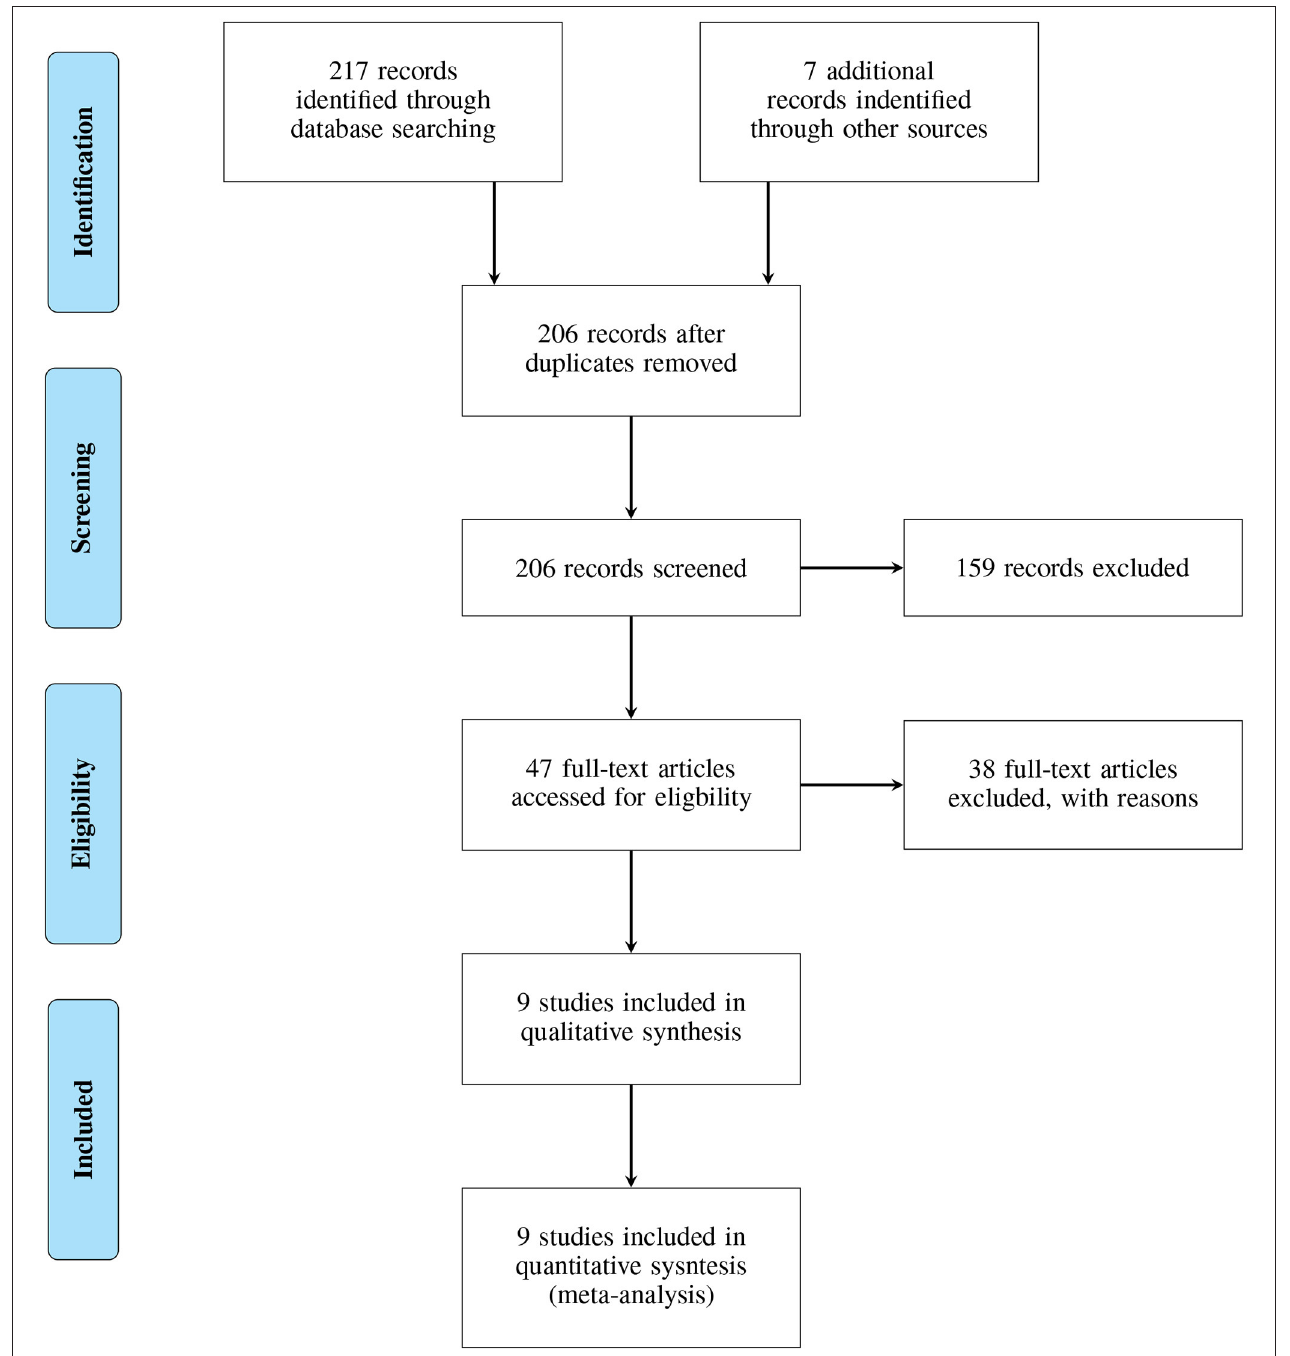
FIGURE 1 | PRISMA 2019 flow